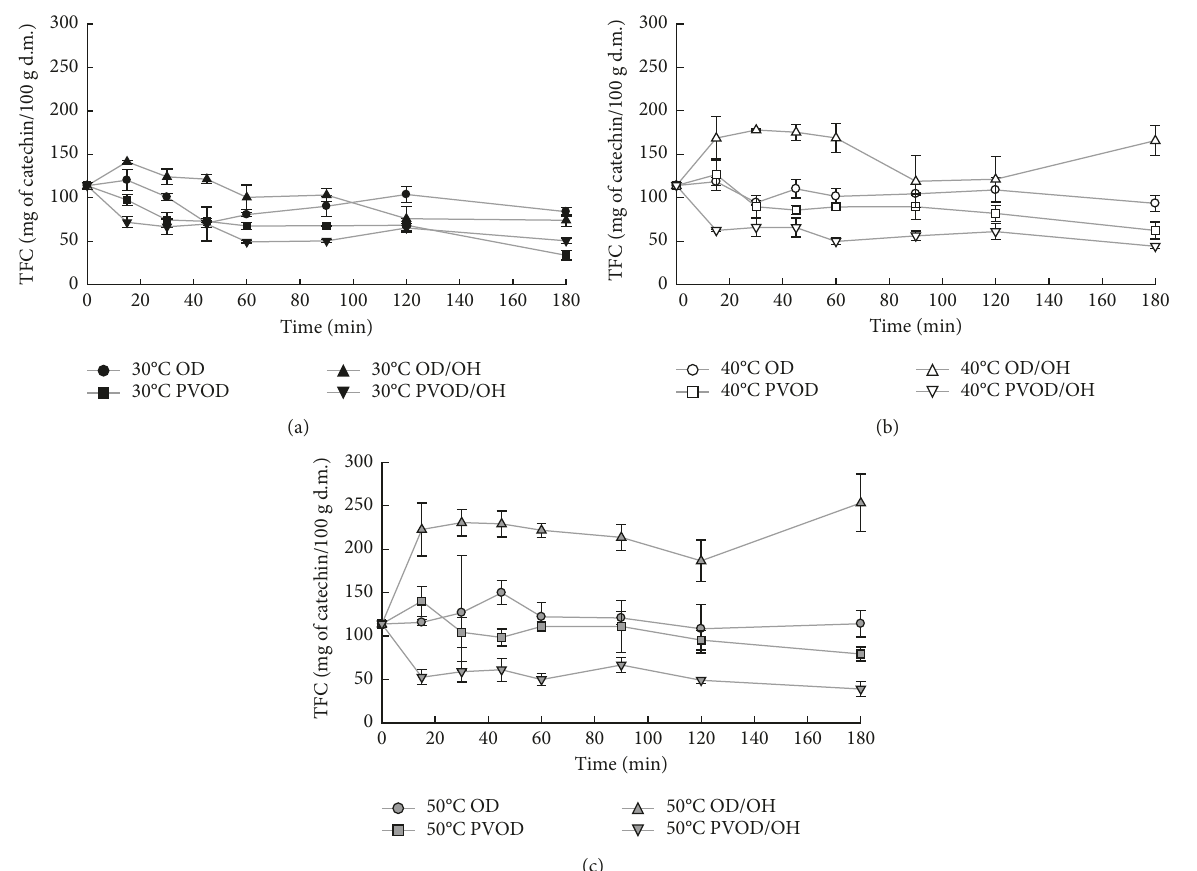
Figure 4: Total flavonoid content (TFC) kinetics of osmodehydrated apple using cryoconcentrated pomegranate juice (47 ° Brix) for 180min at. OD: osmotic dehydration at atmospheric pressure; PVOD: osmotic dehydration with pulsed vacuum; OH: ohmic heating (OD/OH and PVOD/OH) at 6.66V/cm. (a) 30 ° C; (b) 40 ° C; (c) 50 ° C. Table 1: Composition parameters of fresh and processed samples (processing time: 180min), water mass fraction ( X M w M ss a fraction ( X ss ), water loss ( t ), solid gain ( t ), and water activity ( w Δ Δ